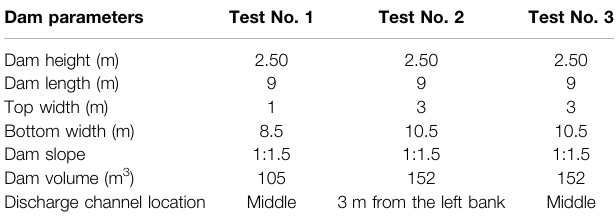
TABLE 2 | Summary of test condition for this